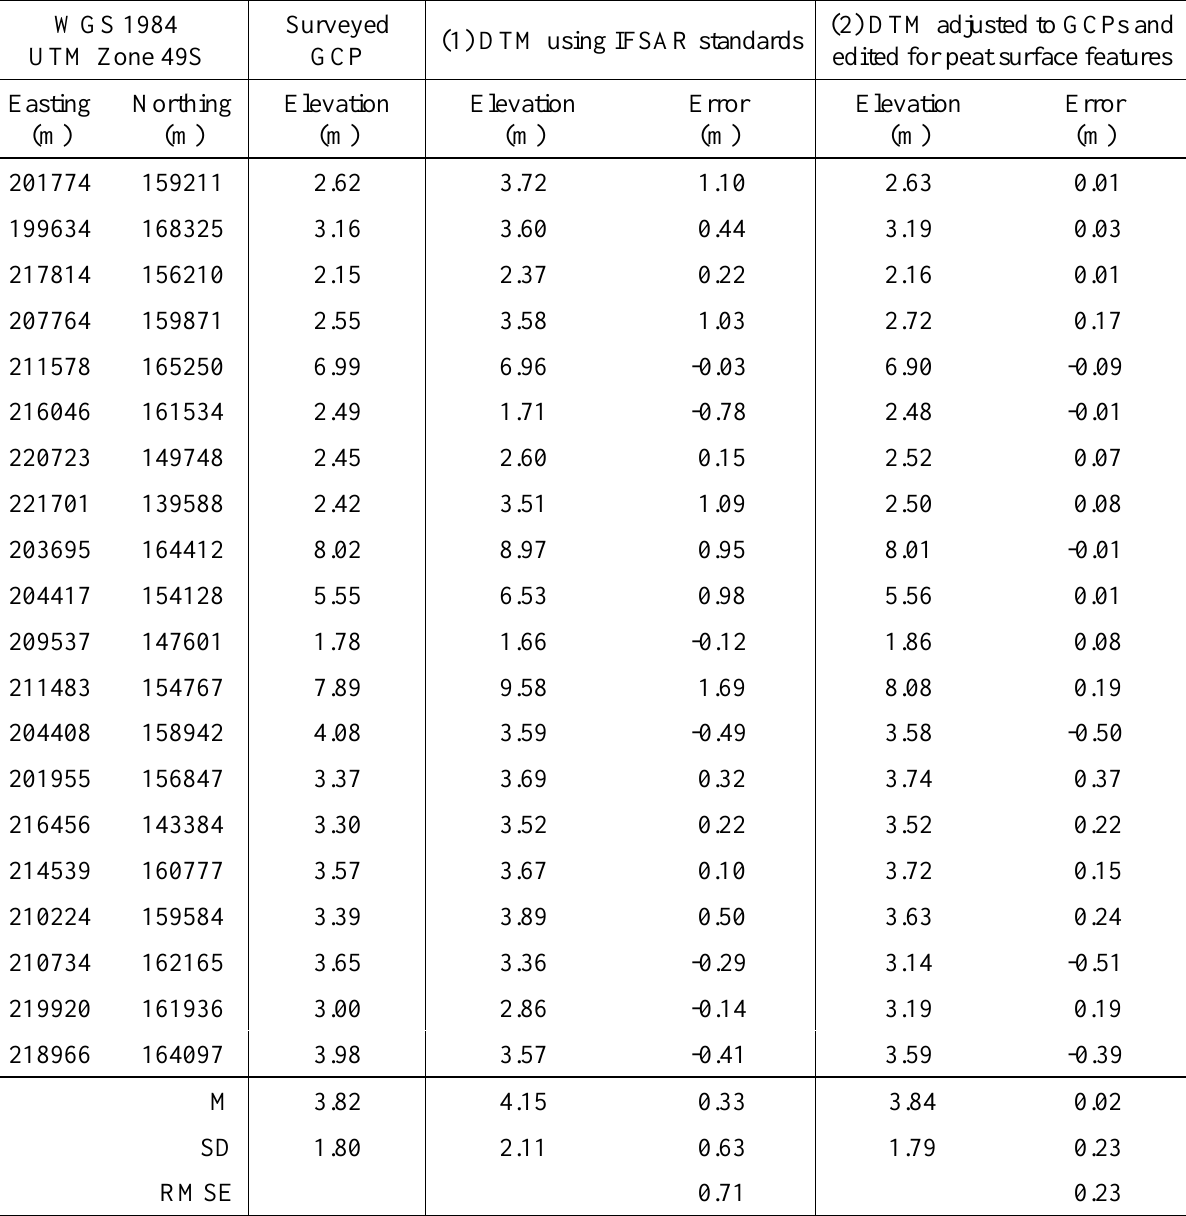
Table A2. Accuracy of the DTM at Kubu Raya by comparison with surveyed Ground Control Points (GCPs); (1) after standard processing from an IFSAR DSM and (2) after further processing to include ongoing peat surface dynamics and exclude man-made